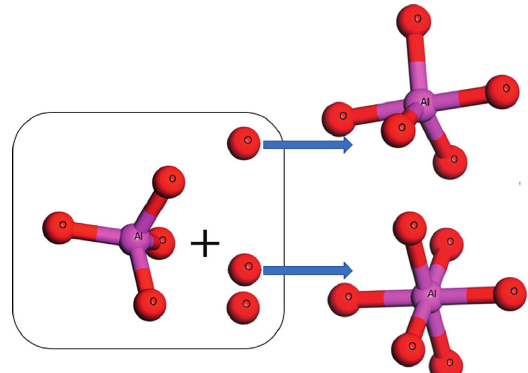
Figure 8: Schematic diagram of [AlO generate higher average coordination